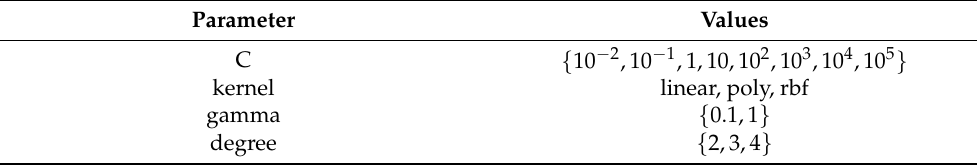
Table 4. Parameters used for the grid search of the